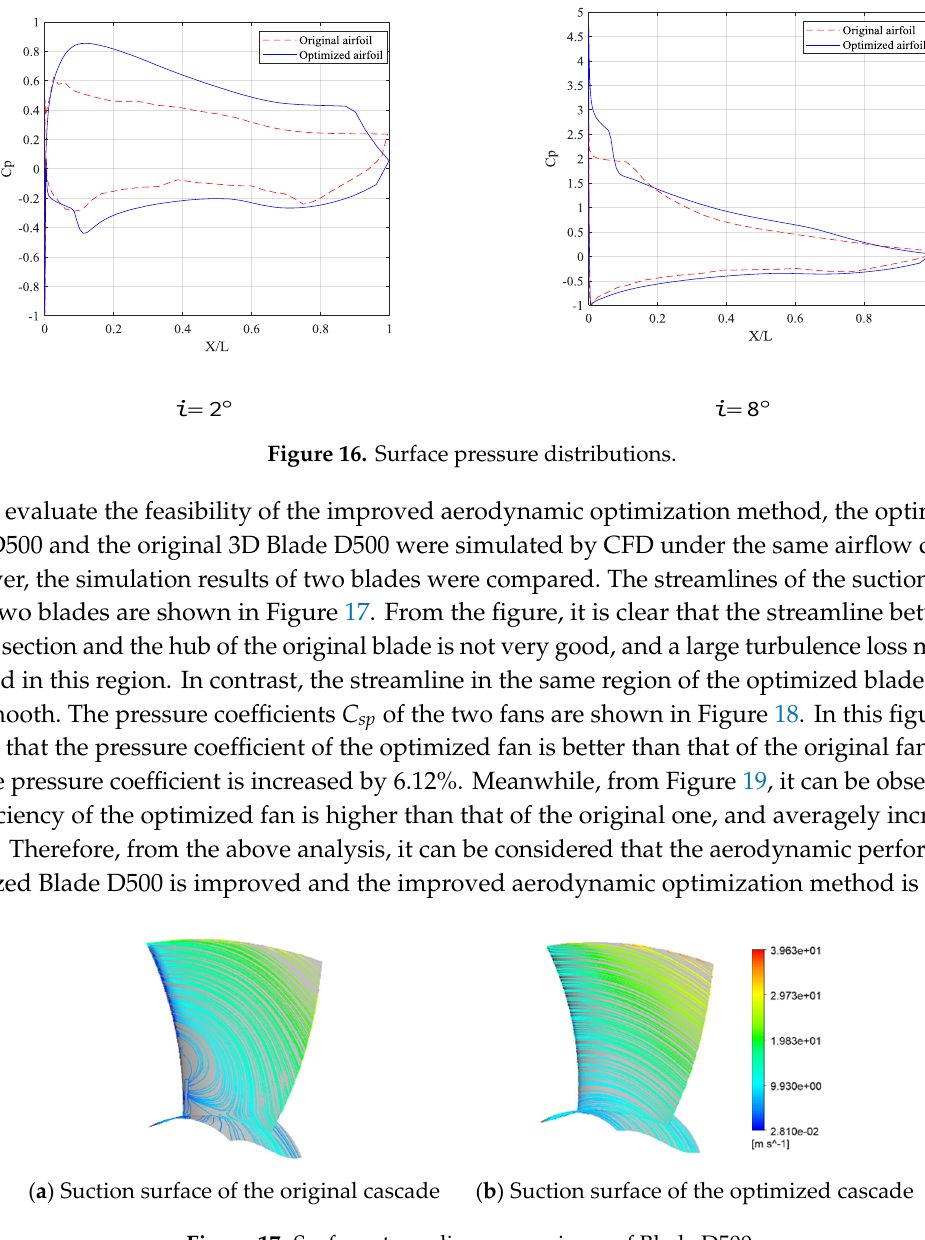
Figure 18. Pressure coefficient comparisons of Blade D500.